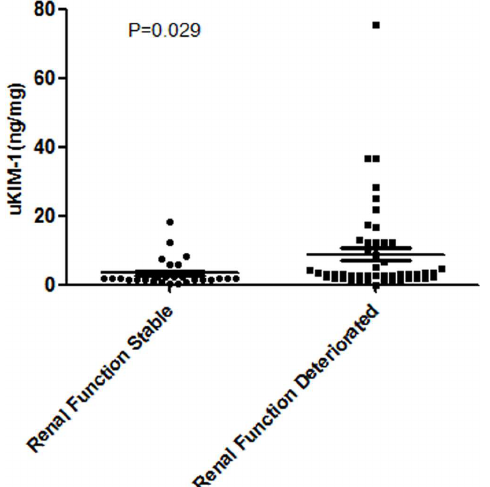
Fig 4. The uKIM-1 level of the progressive deterioration of renal function group was significantly higher than that of the renal function stable group among elderly patients with AKI.